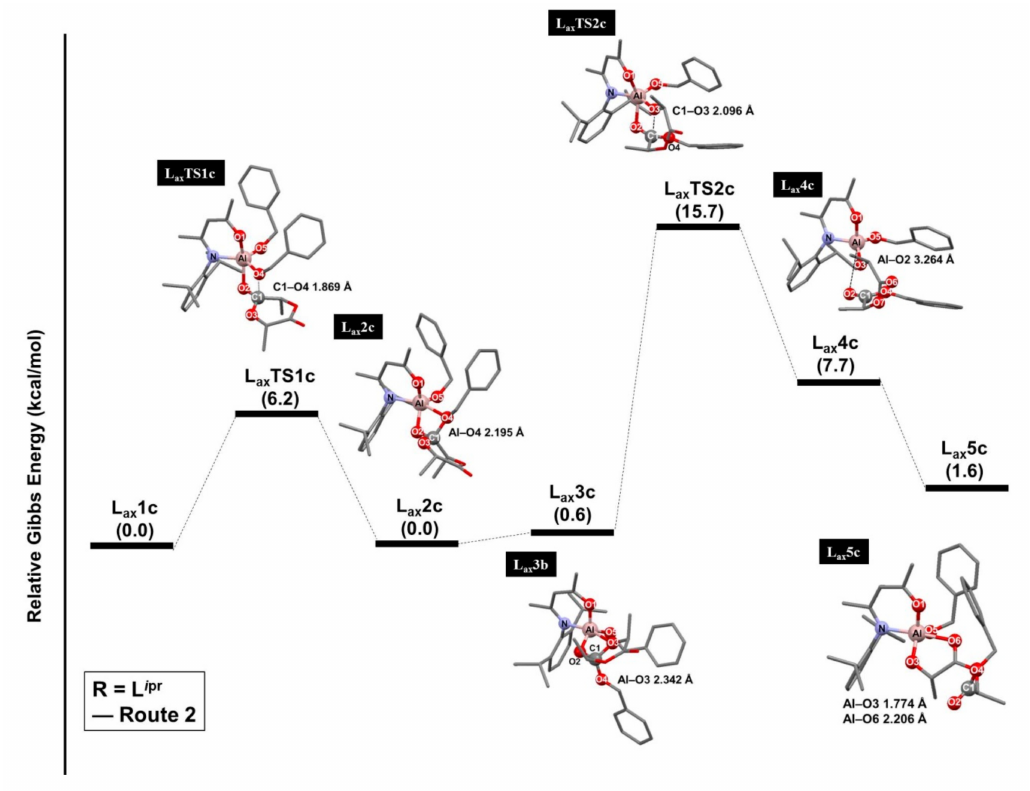
Figure 11. Reaction profile and optimized structures of the L i Pr system. (Monomer: L